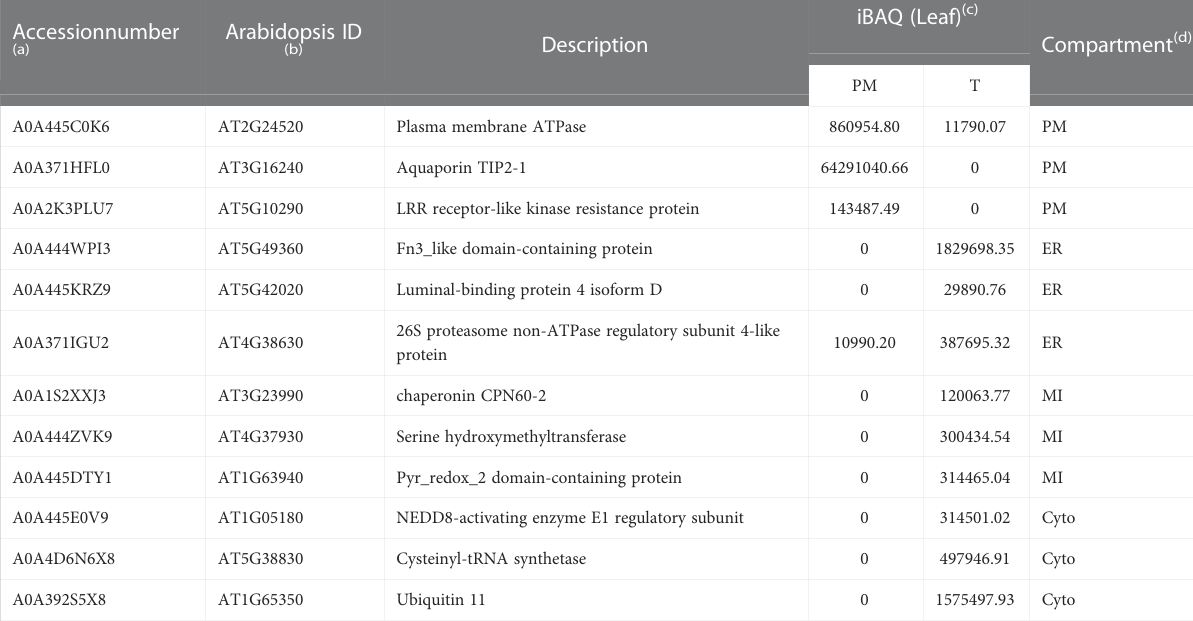
TABLE 1 Representative list of PM, ER, MI and Cyto proteins in PM and T fractions of leaves measured by mass spectrometry.